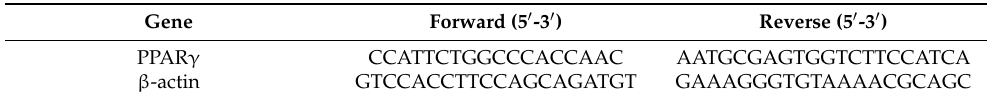
Table 1. Quantitative PCR primers used in this study. Gene Forward (5 (cid:48) -3 (cid:48) ) Reverse (5 (cid:48) -3 (cid:48)